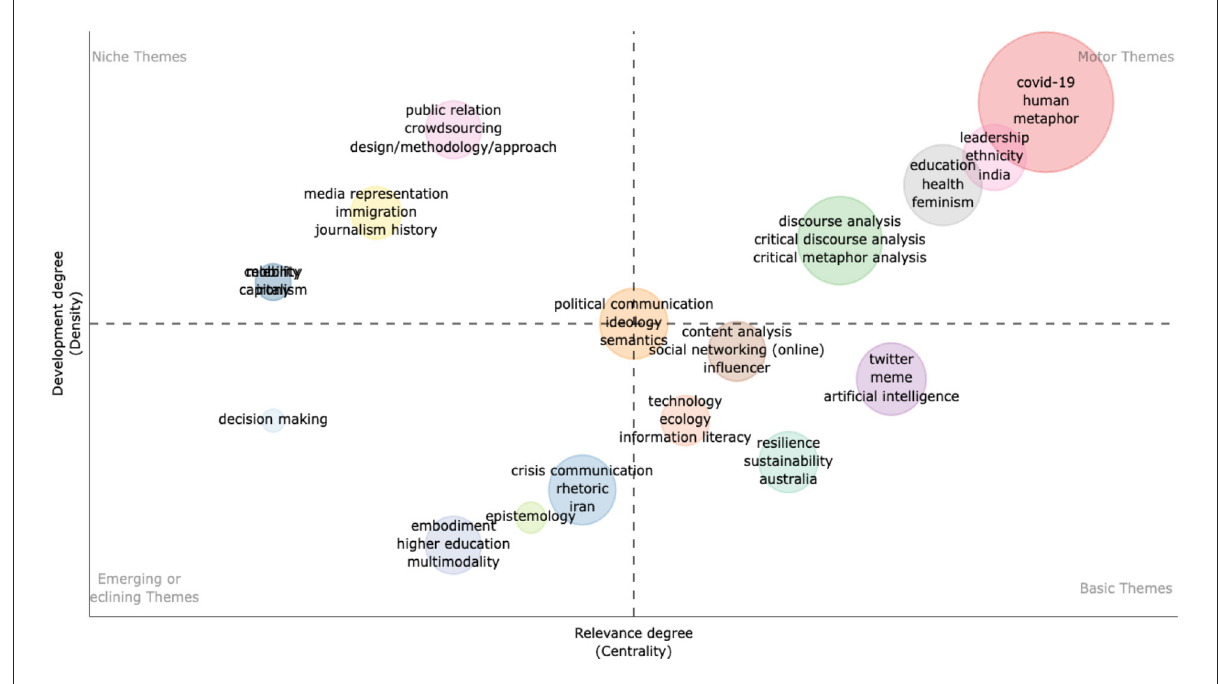
FIGURE6 Visualization of thematic mapping.